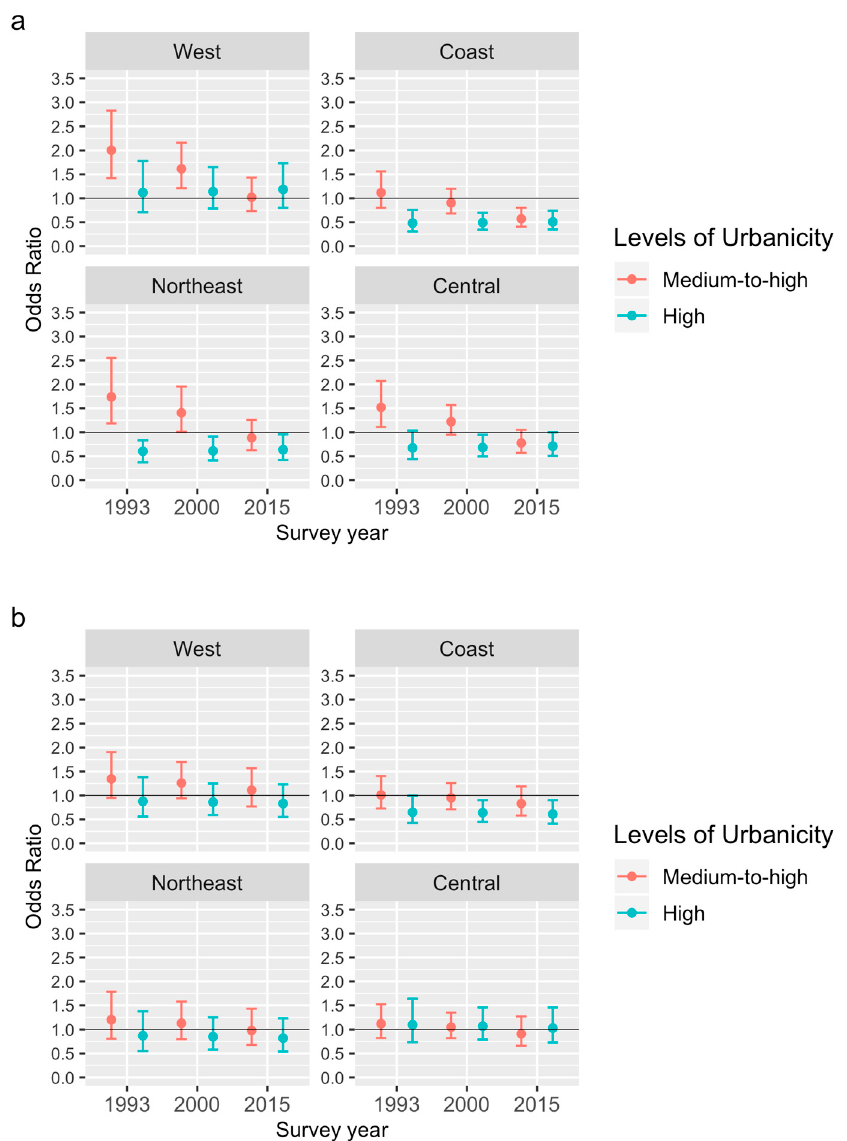
Figure 2. Odds ratio of getting hypertension during the follow-up surveys (the medium-to-high urbanicity, the high urbanicity, versus the low urbanicity) among women ( a ) and men ( b ) by region and survey year.